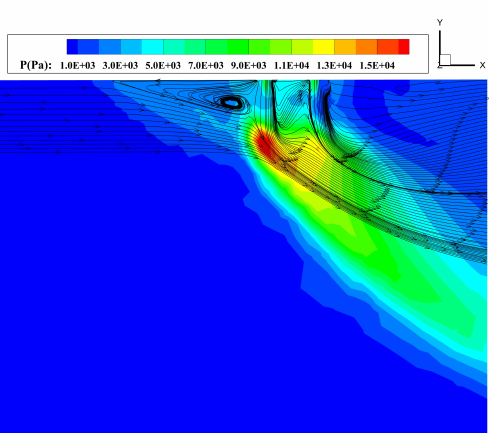
Figure 15. Spanwise 0.116 Section Plane Pressure Contour and Streamlines from Case 6.